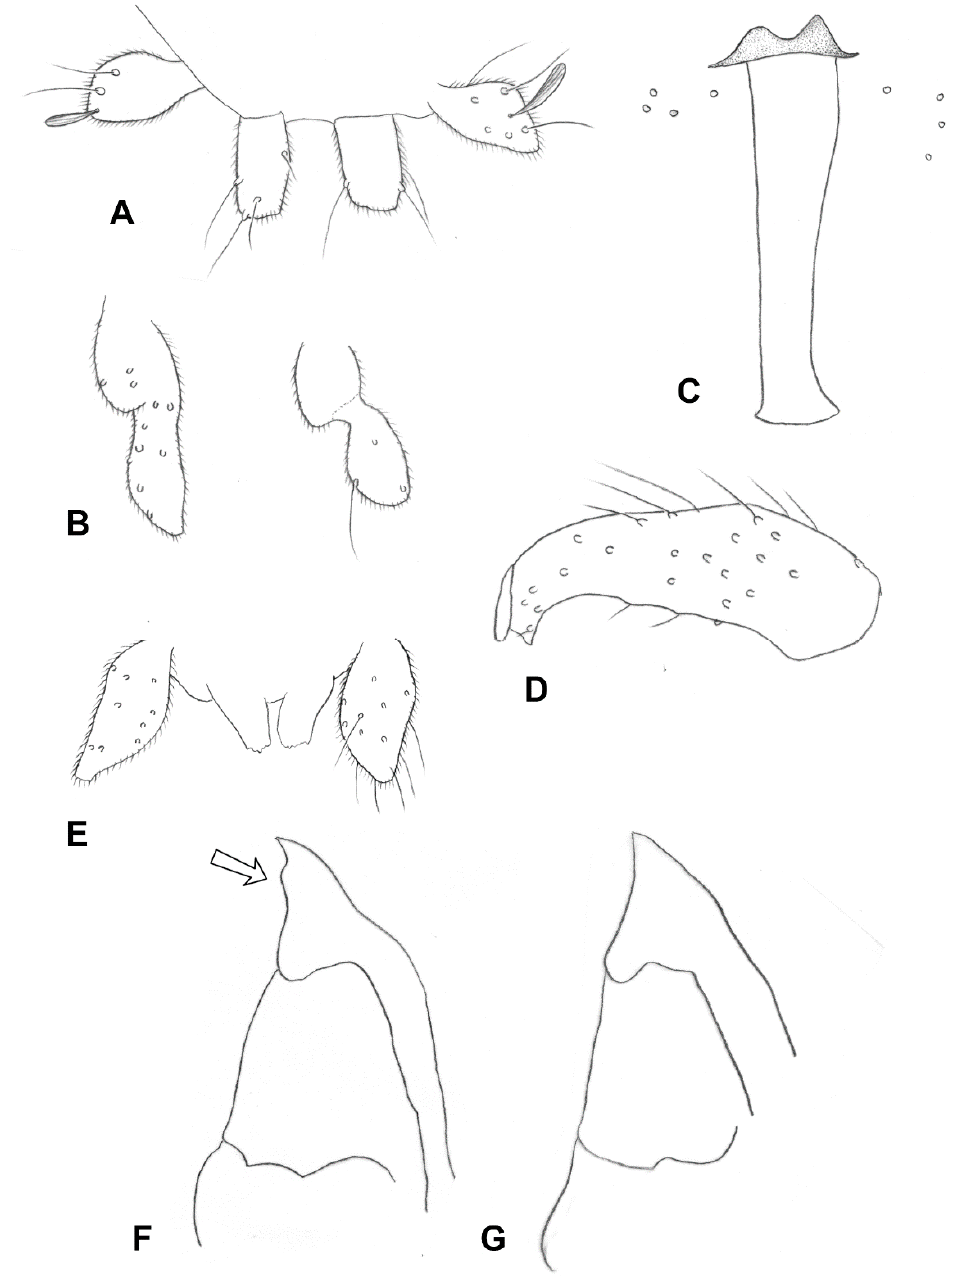
Figure 16. Ruschiola spp. ( A ) R. leipoldtiae , palpi and labella. ( B ) R. leipoldtiae , variation in palpus mor- phology. ( C ) R. leipoldtiae , larval spatula and associated papillae. ( D ) R. leipoldtiae , male gonostylus, dorsal. ( E ) R. celebrata , palpi and labella. ( F ) R. celebrata , pupal exuviae, head, lateral. (Arrow: bulge on antennal horn). ( G ) R. succulenta , pupal exuviae, head, lateral. Thorax : Wing length: 1.93–2.32 mm in female ( n = 44), 1.60–2.18 mm in male ( n = 38). Male abdomen : Gonostylus widest at proximal third, distal margin almost straight rather than arched (Figure 16D). Hypoproct truncated or with shallow